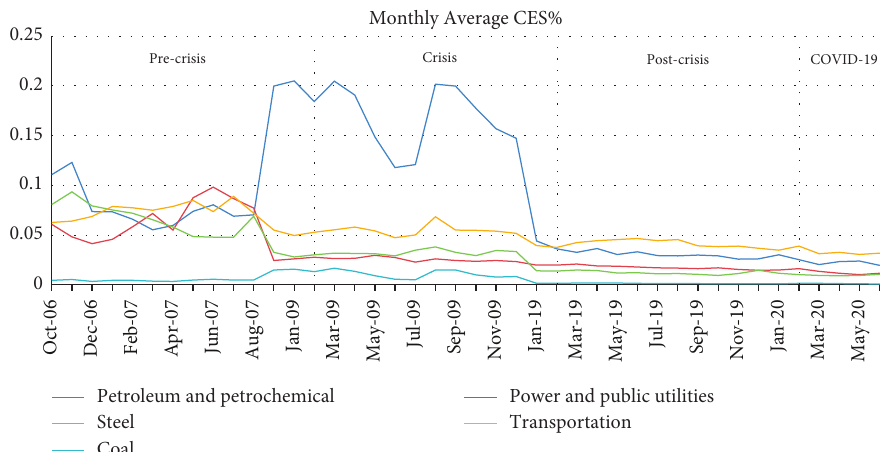
Figure 9: CES of the petroleum and petrochemicals, power and public utilities, steel, and transportation sectors in four periods (%).